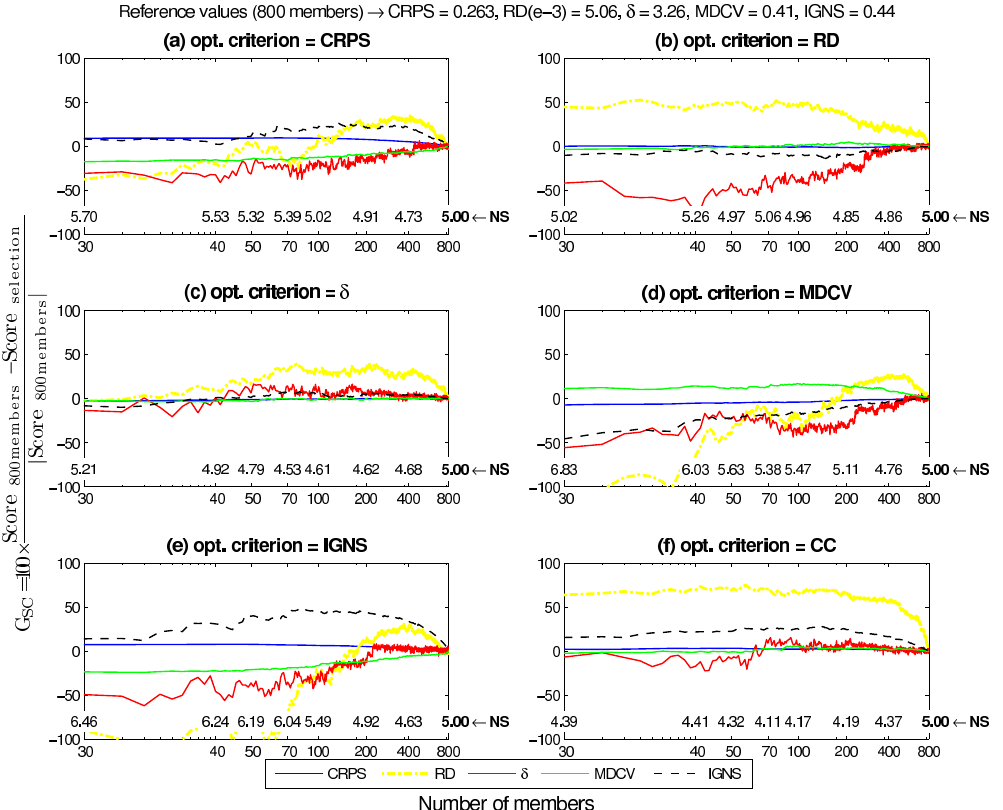
Fig. 5. Evolution of the gain index for each score under different optimization schemes in the basin A79 for the lead time 9. A logarithmic scale is used on the x-axis. The chosen optimization criterion in the selection is shown at the top of each subfigure. The lower part of each subfigure indicates the values of the normalized sum (NS) for the number of hydrological members shown on the x-axis.